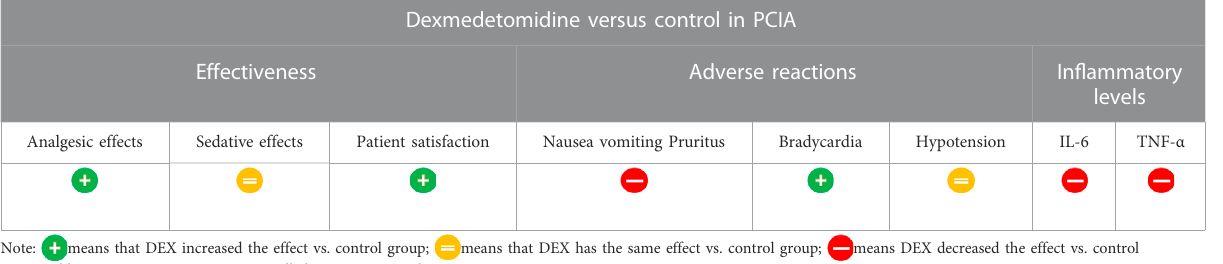
TABLE 3 The summary of the ef fi cacy of DEX in PCIA.